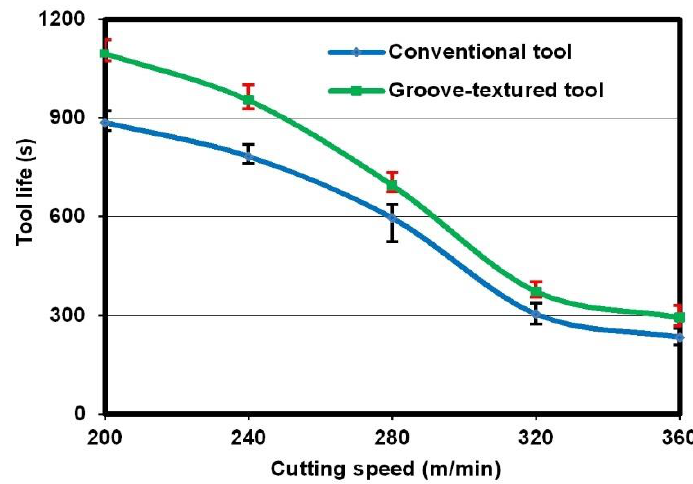
Figure 5. Tool lives obtained under different cutting conditions.